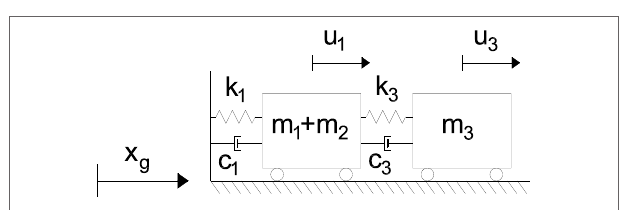
FigUre 5 | Simplified 2DOF system. u 1 is the relative displacement between the roof and the ground; u 3 is the relative displacement between the hoist and the roof.